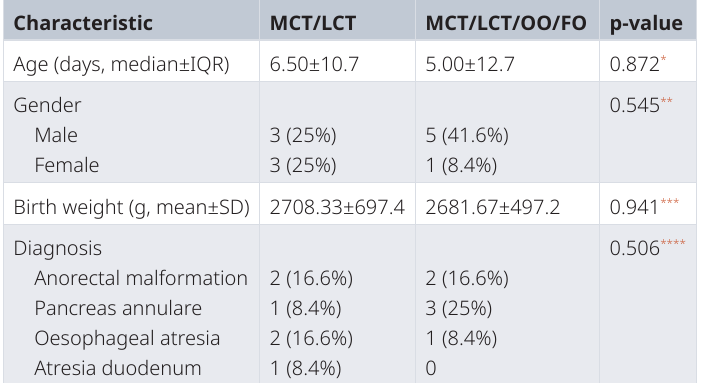
Table 2. Subject